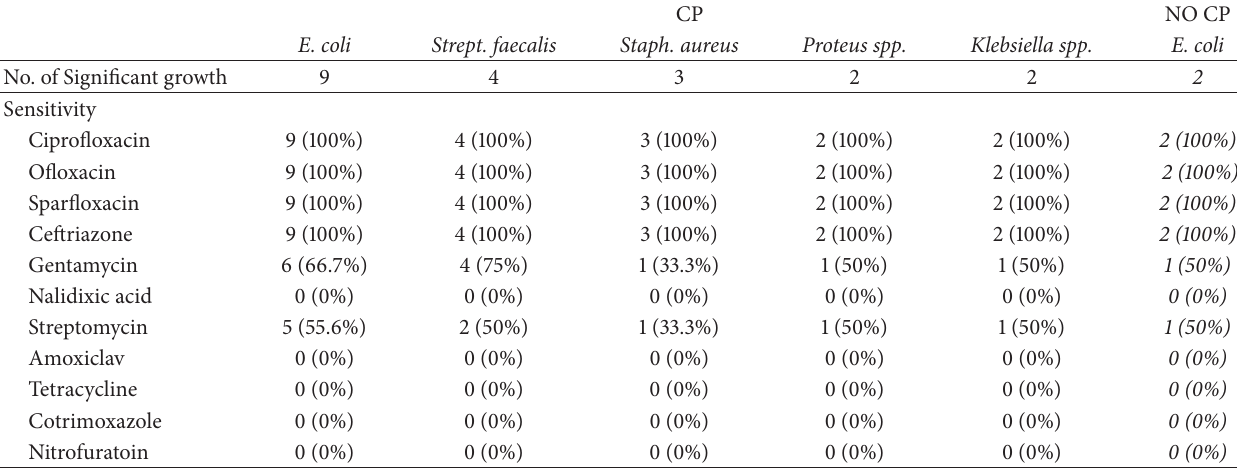
Table 3: Urinary culture and sensitivity patterns among subjects with cerebral palsy and controls without cerebral